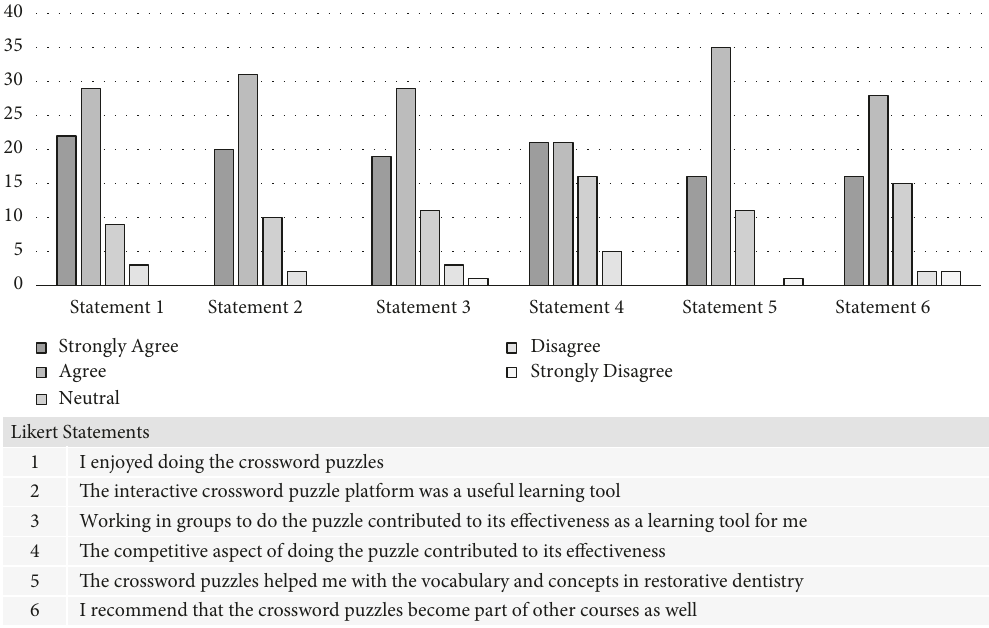
Figure 4: Students’ responses to the questionnaire on their perceptions about the interactive crossword